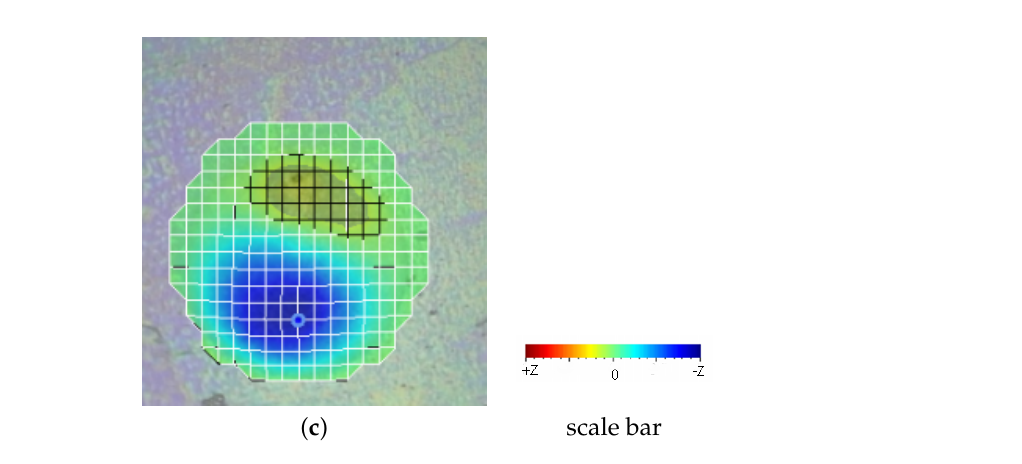
Figure 6. The mode shape of graphene/PMMA membrane over closed cavity resonator at resonant frequencies under ( a ) mechanical actuation (0.5 V AC, 1 V DC); (( b ) electro-static actuation (3V AC,